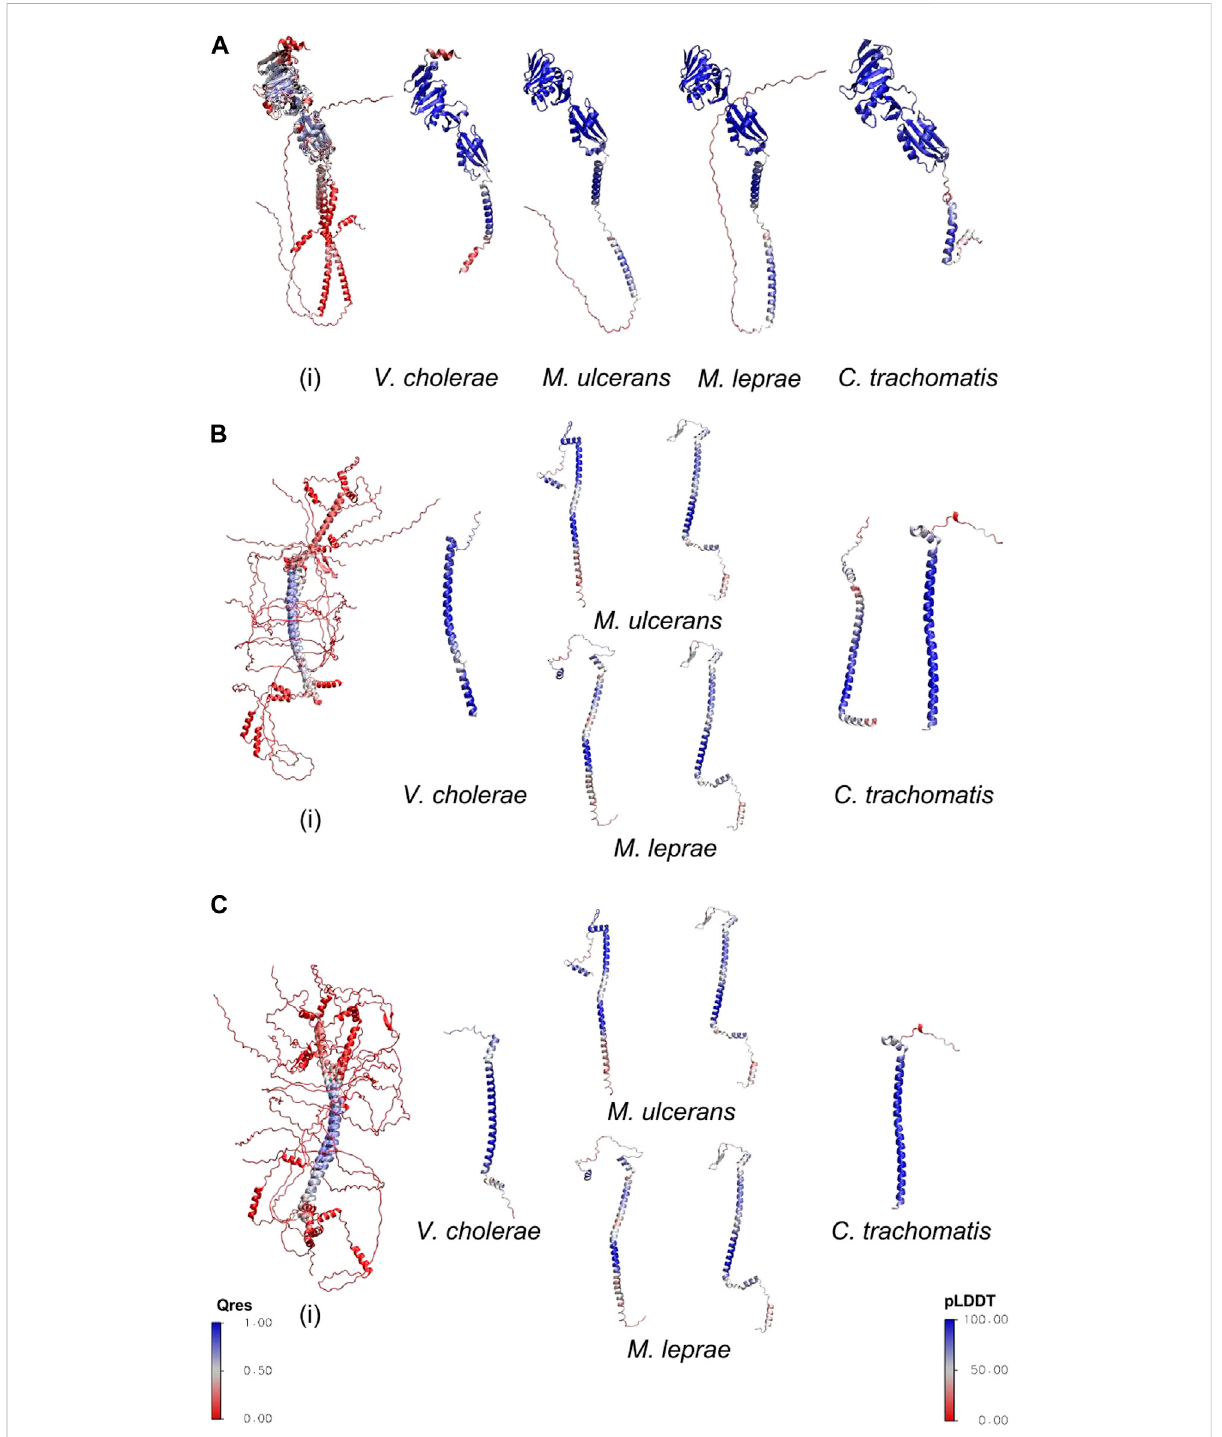
FIGURE 1 (A) The predicted structures of homologs superimposed with the experimental structure of E. coli FtsQ(PDB ID 2vh1). (B) The predicted structures of candidate homologs superimposed with FtsB homolog of E. coli (AlphaFold Model). (C) The predicted structures of remote homologs superimposed with FtsL homolog of E. coli (AlphaFold Model). The superimposed structures have been colored on the basis of structural conservation measures (Q-value) with blue being conserved and red variability between their structures. The individual structures of V. cholerae, M. ulcerans, M. leprae , and C. trachomatis are colored on the basis of AlphaFold con fi dence